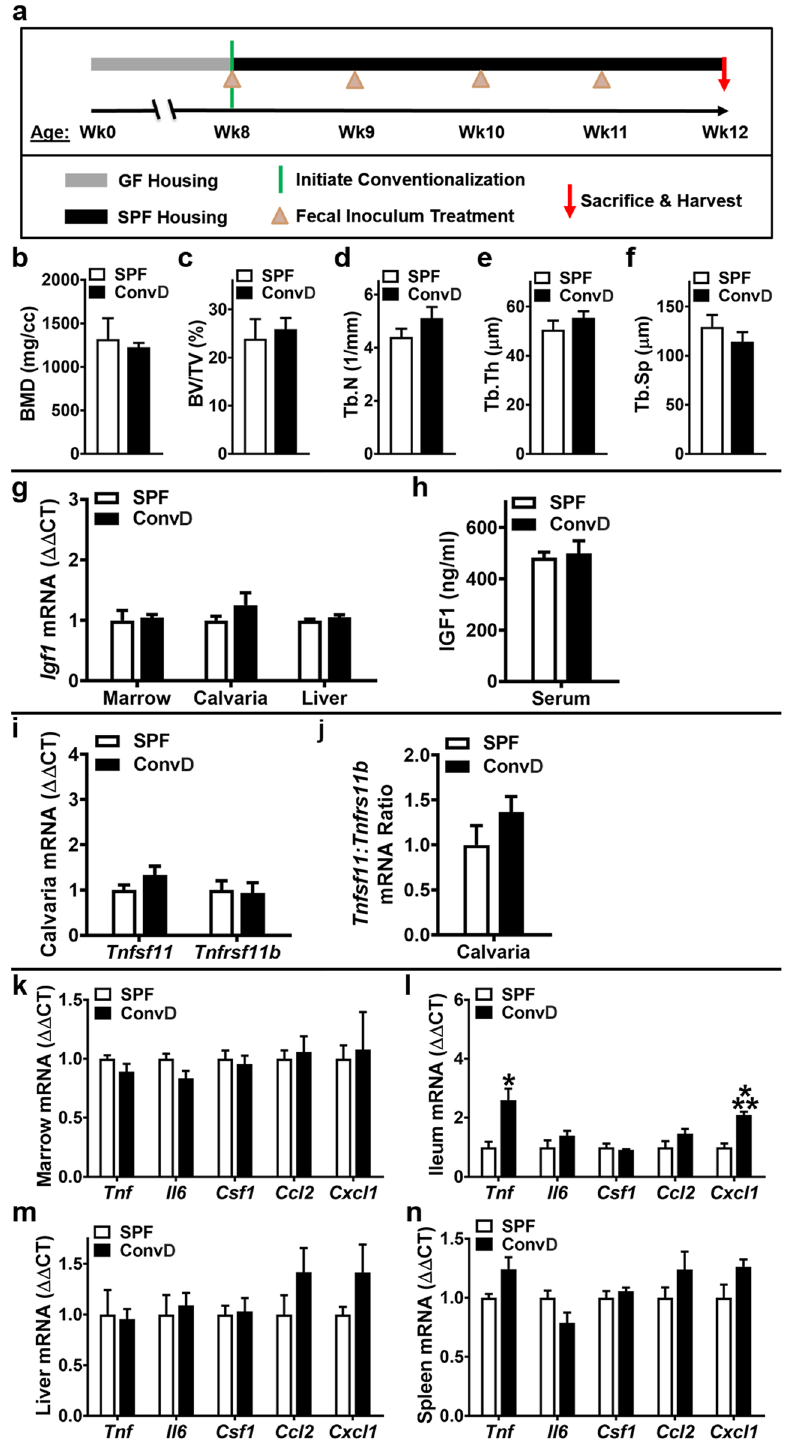
Figure 8. Conventionalization study: GF mice colonized with SPF mice gut microbiota. ( a) Conventionalization study timeline: Conventionalized (ConvD) mice were generated by transferring 8 week- old male GF C57BL/6 littermate mice from sterile isolator housing to ventilated cages in a SPF vivarium. Microbial association was performed via fecal inoculum derived from pooled fresh feces of age matched male SPF C57BL/6 littermate mice, which were housed in the same SPF vivarium. ( b – n ) 12 week-old male SPF & ConvD mice were euthanized; tissues were harvested for analyses. ( b – f ) Trabecular bone analysis: Micro-CT analysis of proximal tibia trabecular bone (n = 4/gp). ( b ) BMD = trabecular bone mineral density. ( c ) BV/ TV = trabecular bone volume fraction. ( d ) Tb.N = trabecular number. ( e ) Tb.Th = trabecular thickness. ( f ) Tb.Sp = trabecular separation. ( g – h ) In vivo regulation of osteoblastogenesis: ( g ) RNA was isolated from marrow (n = 4/gp), calvaria (n = 4/gp), liver (n = 4/gp) for qRT-PCR analysis. Igf1 mRNA assessed as a